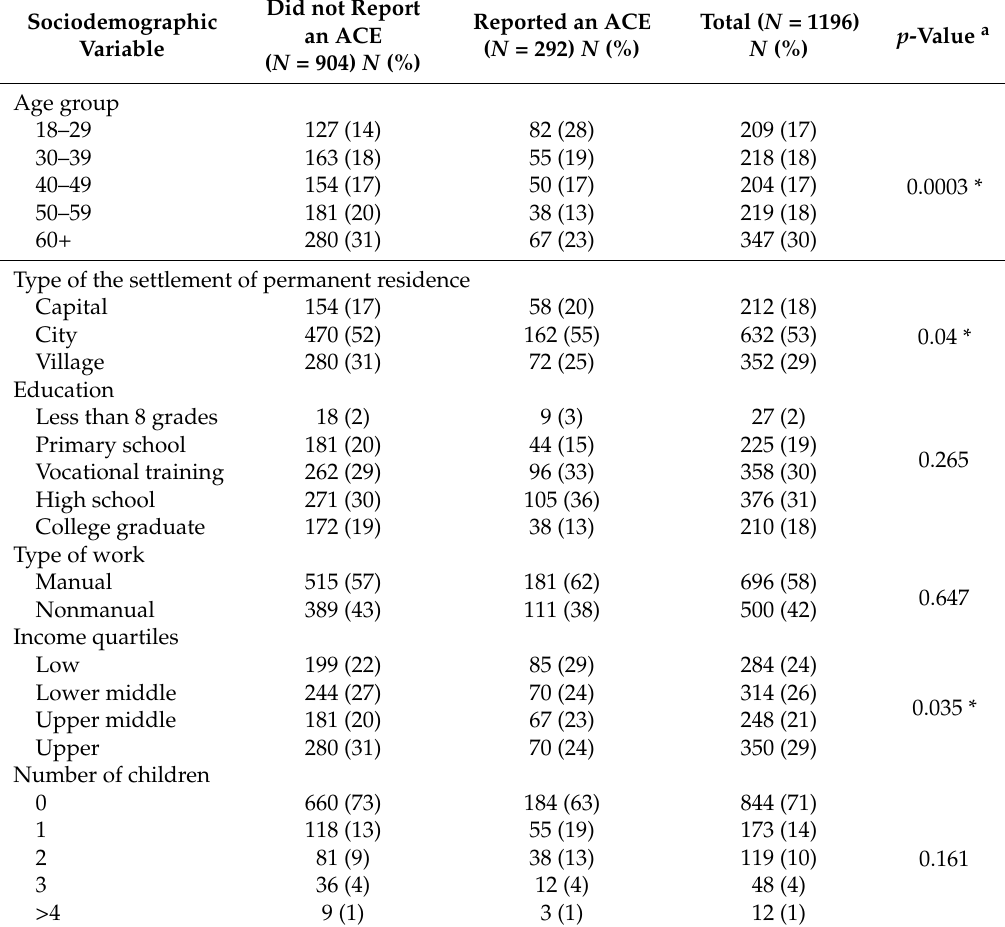
Table 1. Distribution of sociodemographic characteristics by reporting/not reporting an ACE.